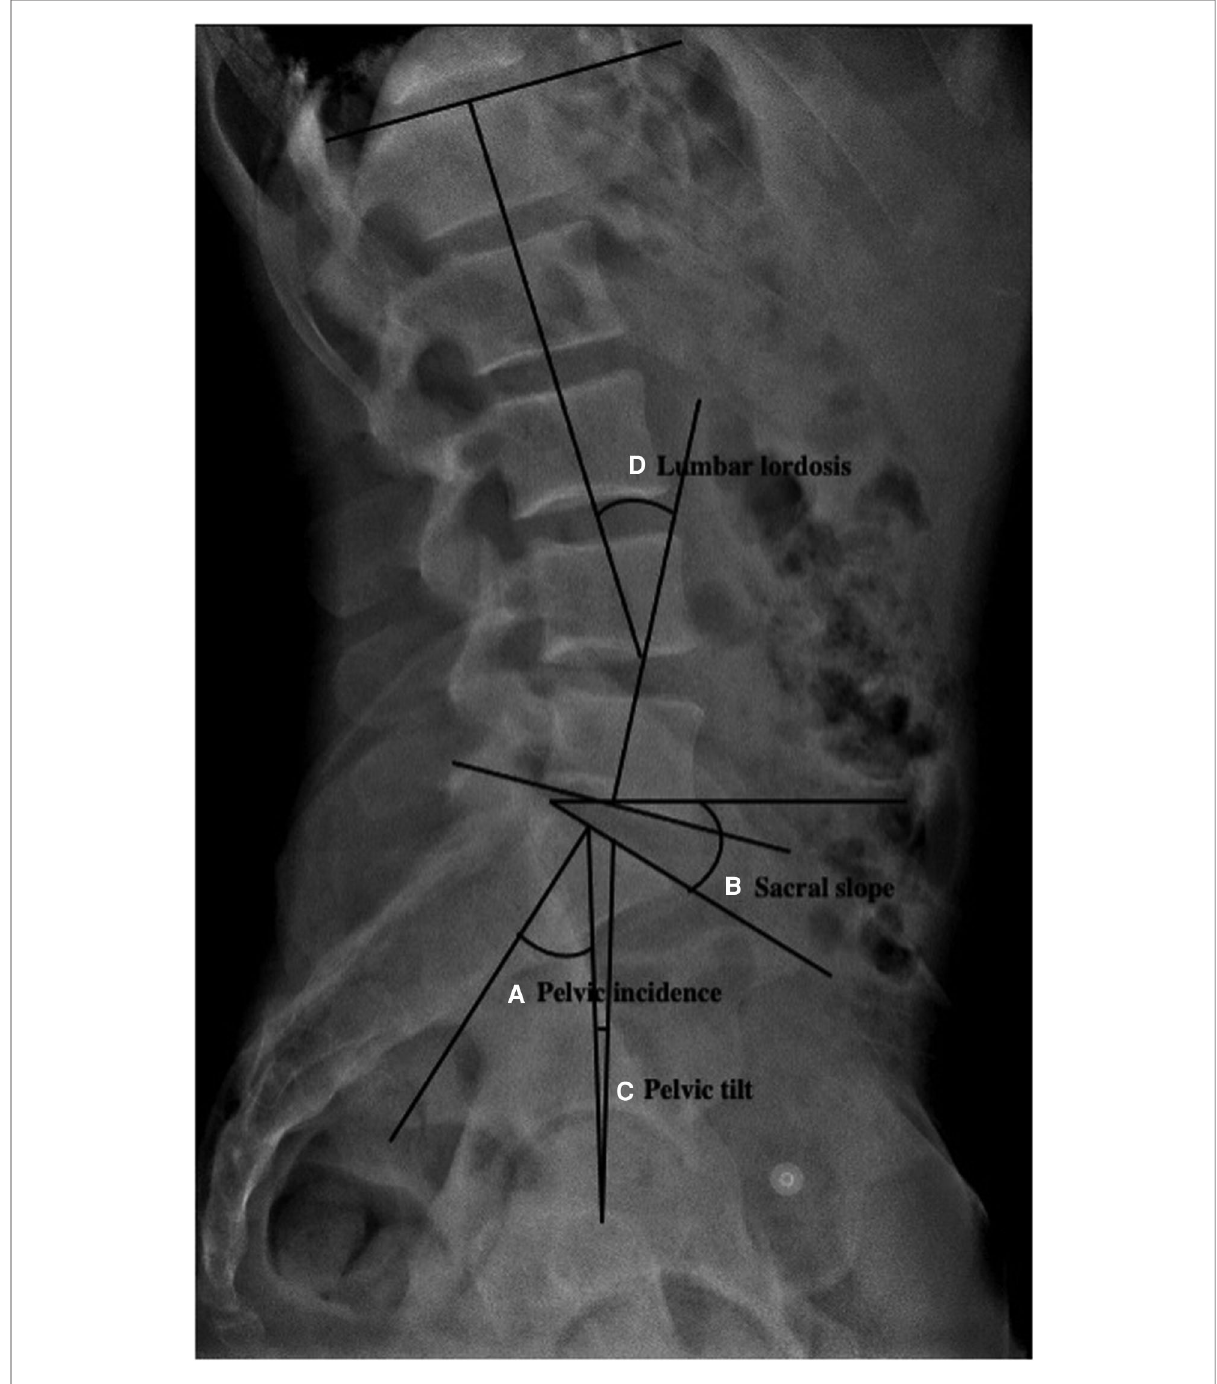
the rectus abdominis (23). Tears and injury to other nearby musculotendinous structures including rectus femoris and iliopsoas tendinosis are associated with anterior hip pain as well (32). Test ’ s including FABER test and tenderness